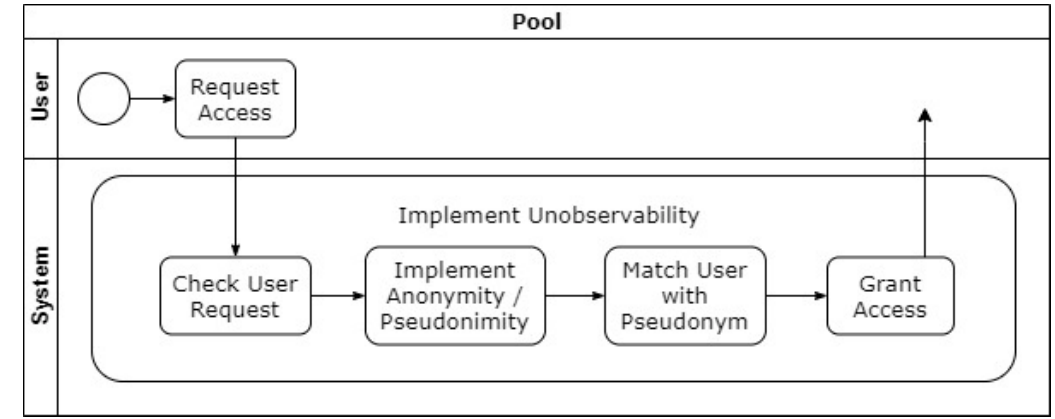
Figure 25. Conceptual overview of Unobservability process pattern [49].